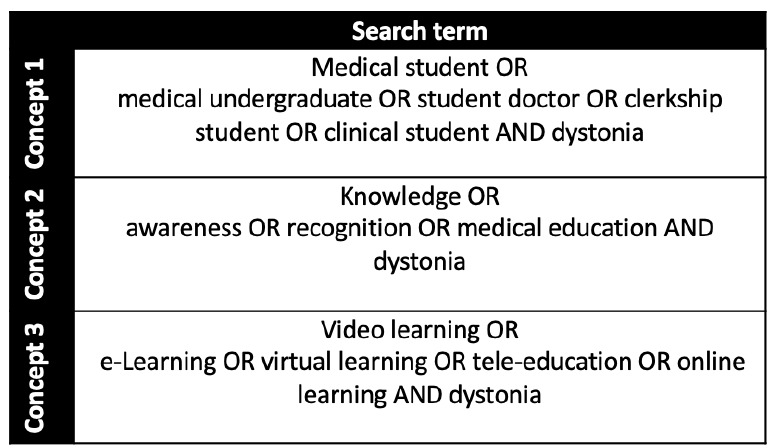
Figure 1. Terms used in scoping search.